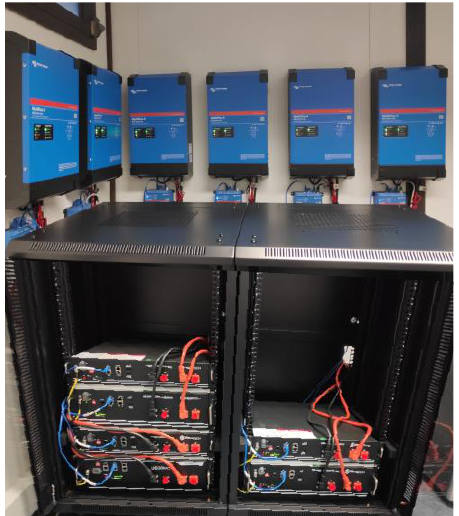
Figure 3. A real BESS from GECAD/ISEP was used for implementing the proposed methodology.